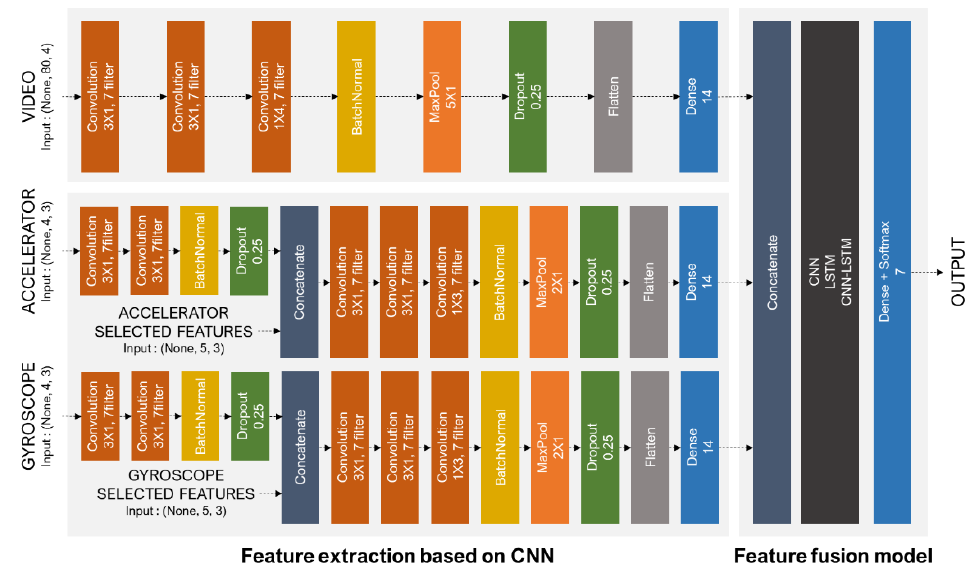
Figure 2. Overall model structure based on the multimodal data for dog behavior recognition.